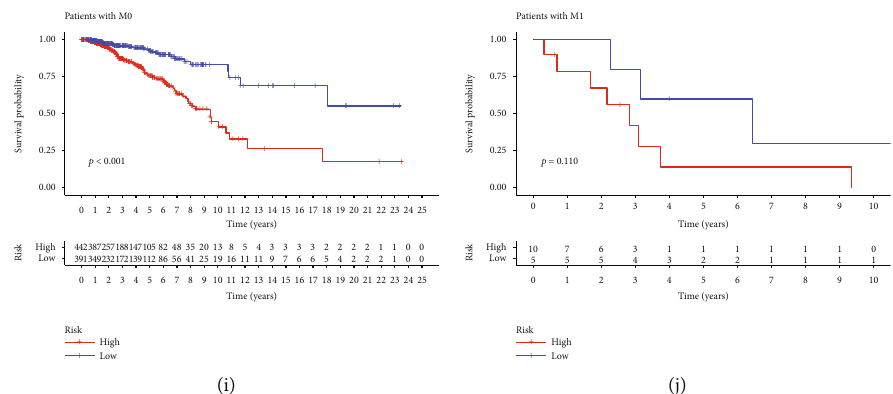
Figure 6: Kaplan-Meier assays in patients (high and low groups) sequenced according to di ff erent clinical-pathological ingredients: (a, b) age; (c, d) stage; (e, f) T stage; (g, h) N stage; (i, j) M stage.